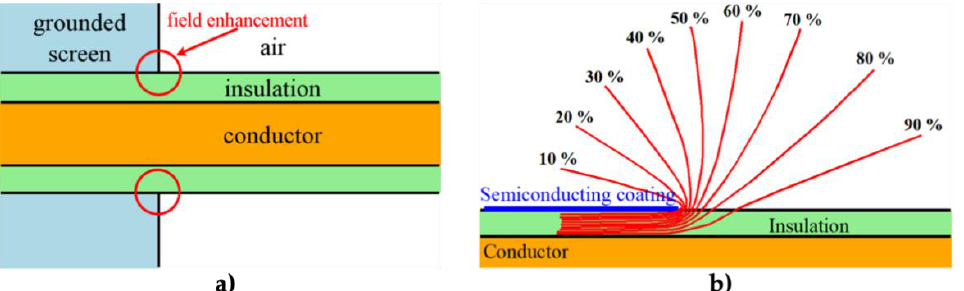
Figure 1. Insulated conductors passing through a grounded metallic screen at HV. ( a ) Typical configuration. © 2021 IEEE. Reprinted, with permission, from Ref. [20]. ( b ) Equipotential and stress distribution due to the termination of the semiconducting coating. © 2021 IEEE. Reprinted, with permission, from Ref. [21].